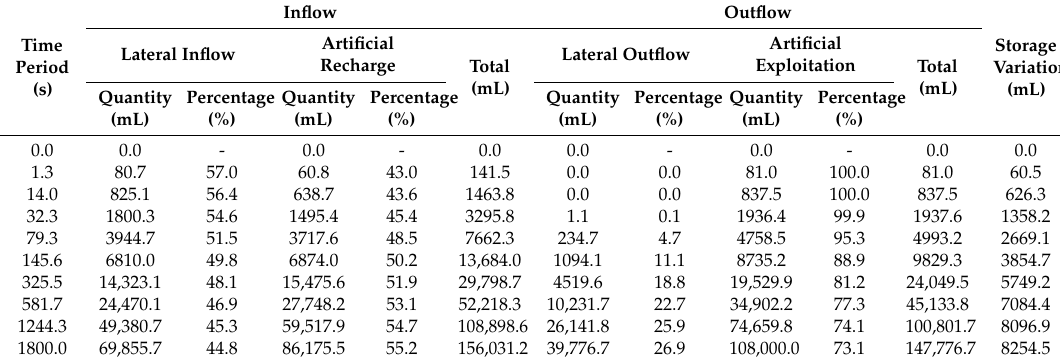
Table 3. Results of water budget.